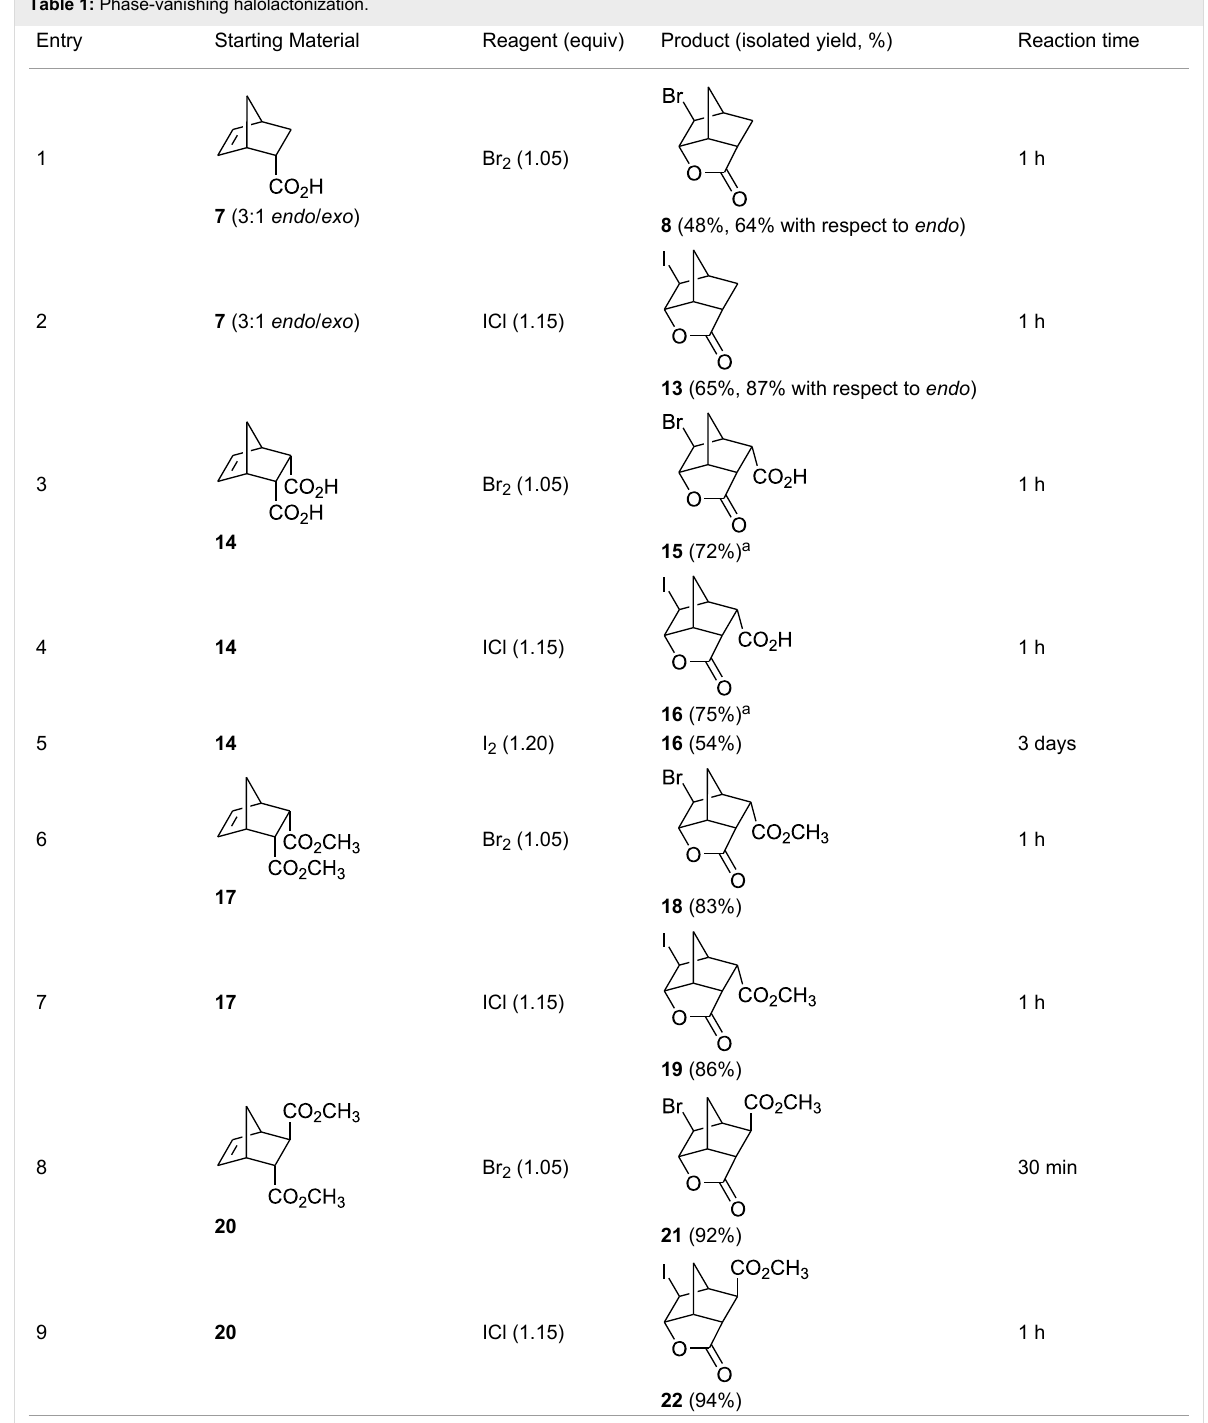
Table 1: Phase-vanishing